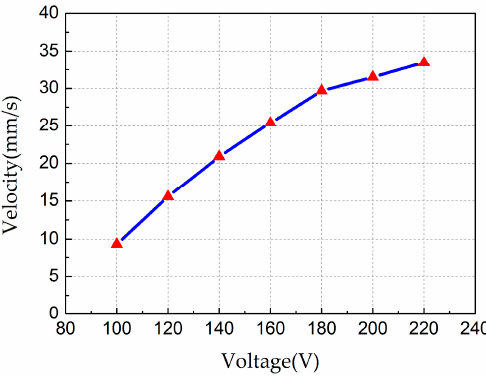
Figure 9. Plot of the output velocity versus the different input voltages.